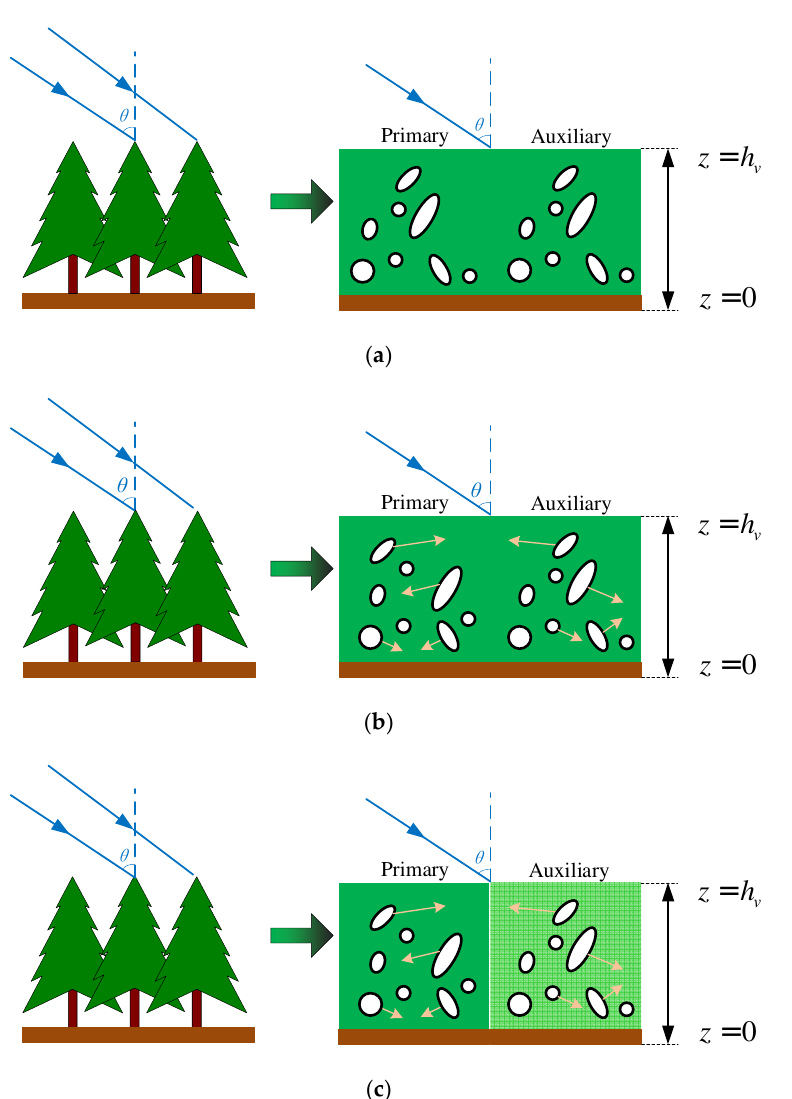
Figure 2. The geometric schematic representation of each model. ( a ) RvoG, ( b ) RmoG, ( c ) DF-RmoG. Equation (1) shows the scattering coherence function of the DF-RMoG model.